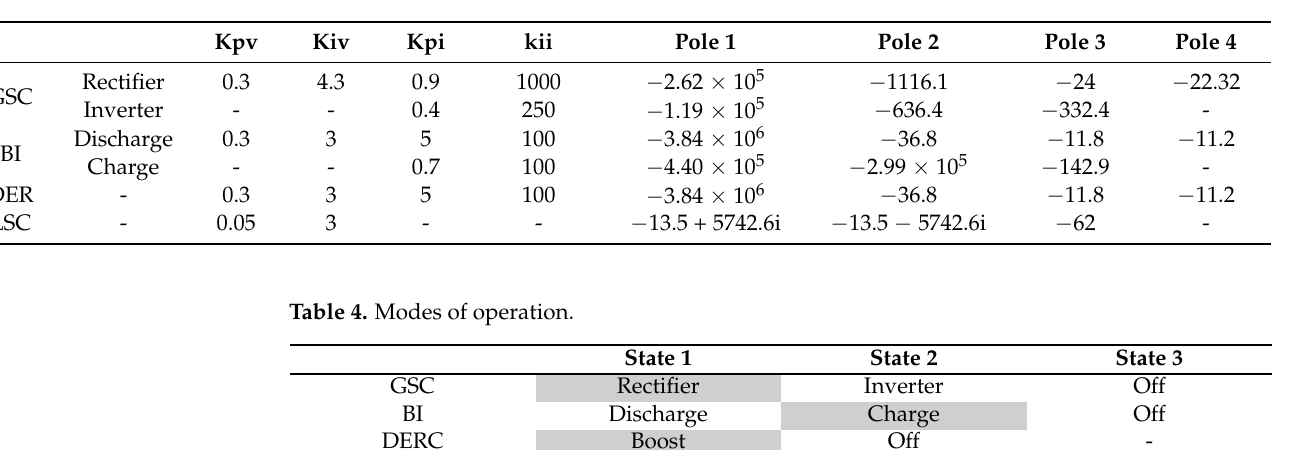
Table 3. Controller gain values and corresponding system poles.